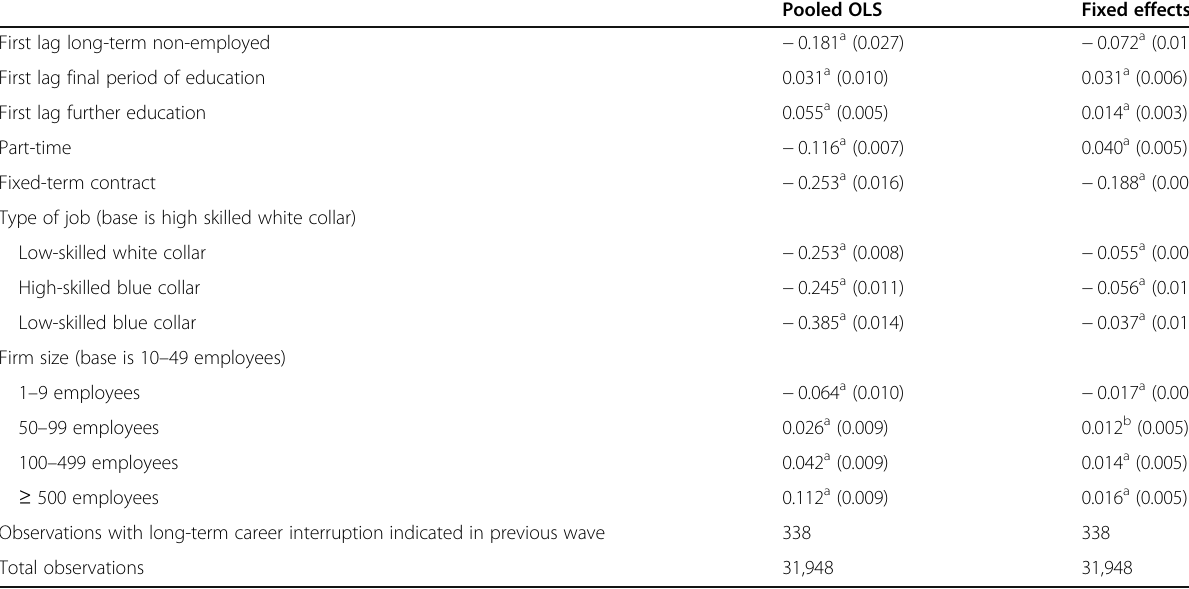
Table 2 Short-run estimates of log real hourly wage equations